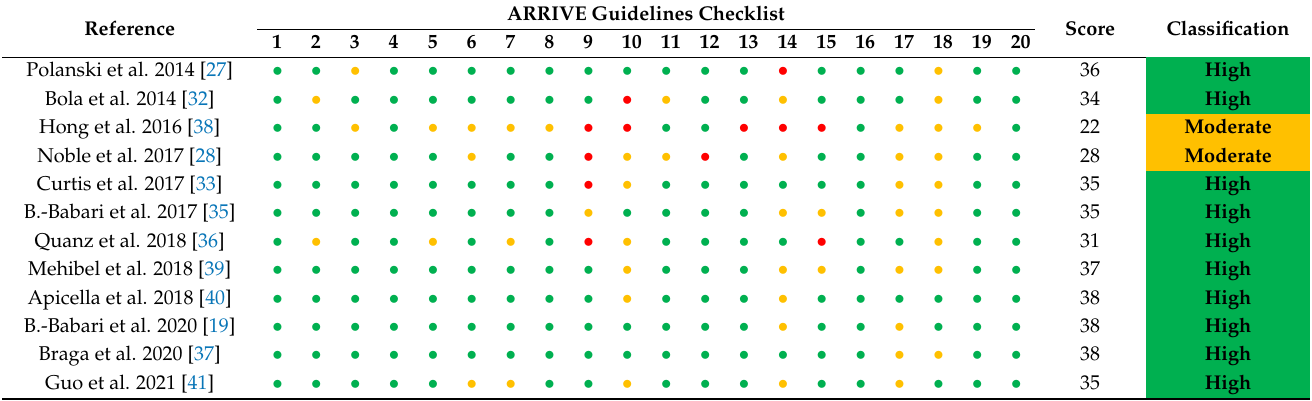
Table 1. Quality assessment of the selected studies based on the ARRIVE Guidelines checklist for animal studies